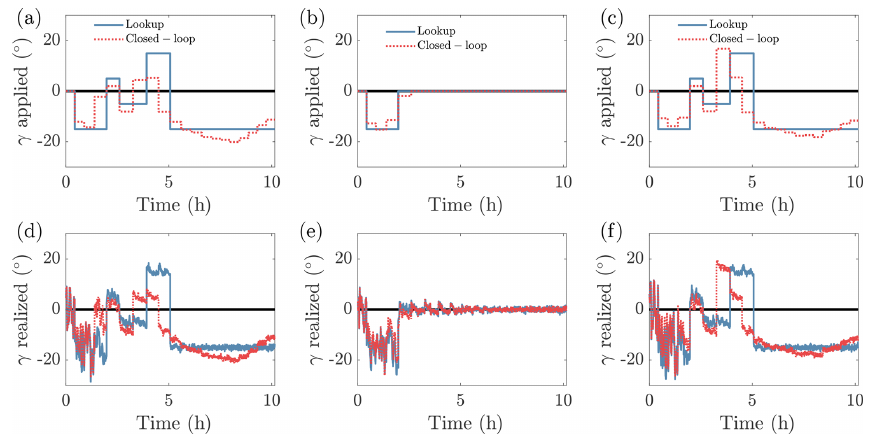
Figure 11. Comparison of the yaw misalignment set-point values as a function of time from the OUU closed-loop control (Case OUU-F) and from open-loop lookup table control (Case L) for turbines (a) 1, (b) 2, and (c) 3. (d–f) Same as (a–c) with realized yaw.